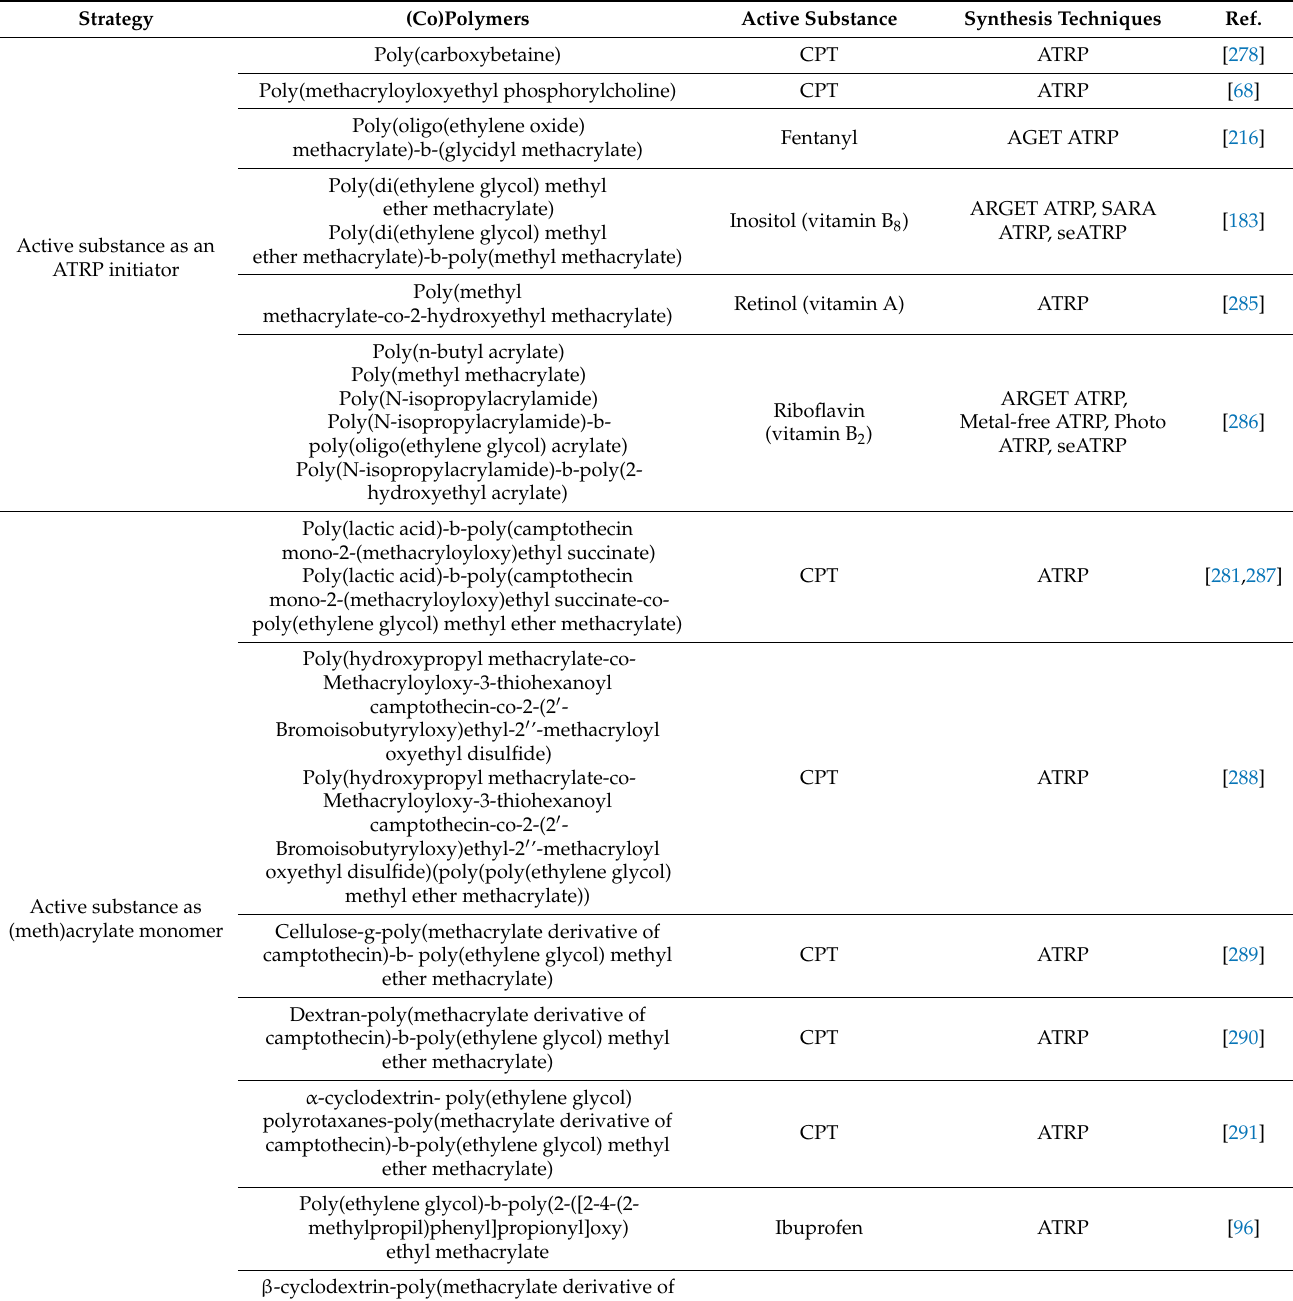
Table 5. A review of the literature on the synthesis of polymer–drug conjugates using ATRP tech-